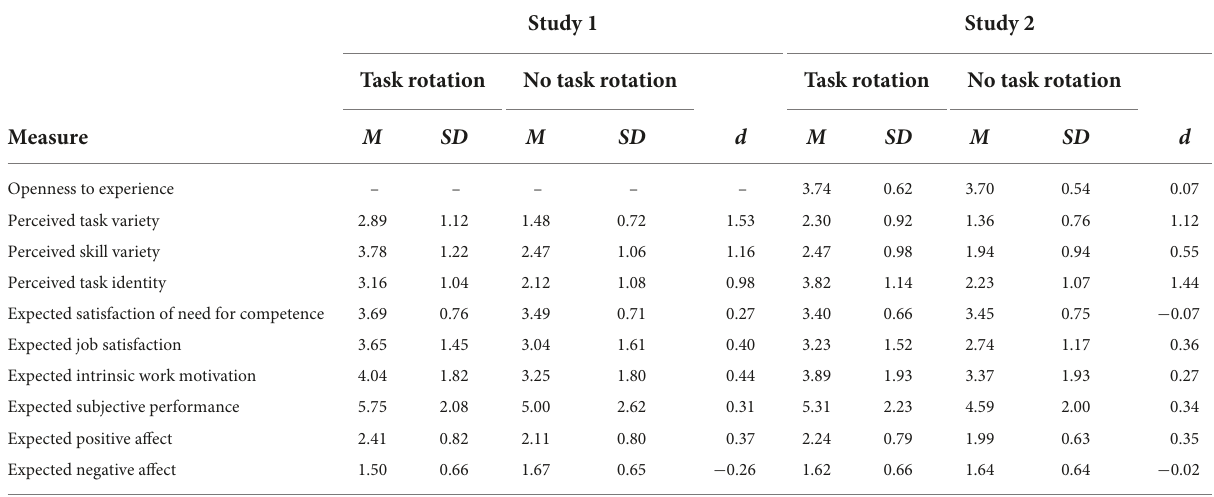
TABLE 3 Means and standard deviations of study variables, and standardized mean differences between experimental